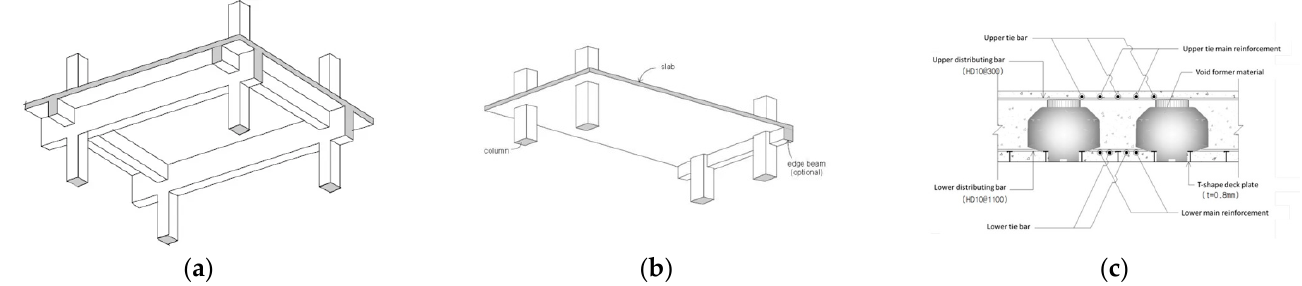
Figure 2. Schematic description of the slab systems: ( a ) Solid slab, ( b ) The flat plate slab, ( c ) The void slab system.